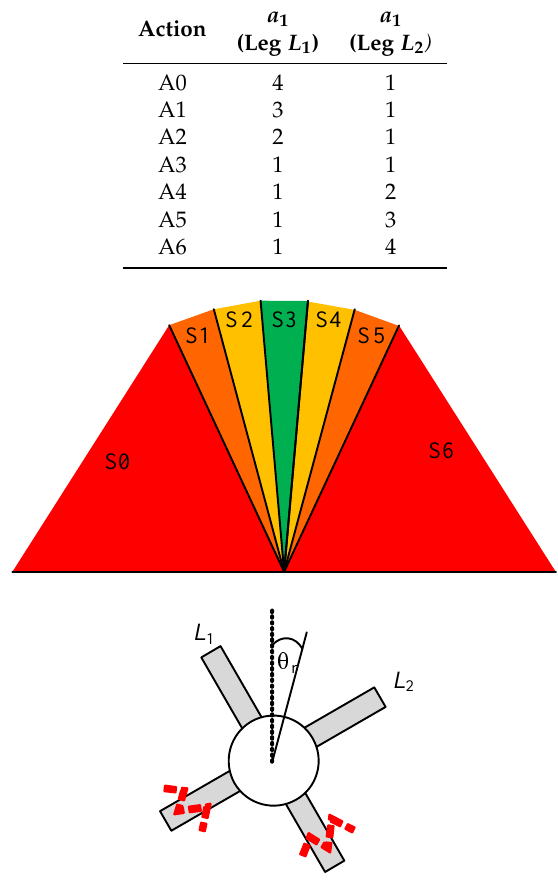
Figure 14. State space of Q-algorithm for robot orientation θ r